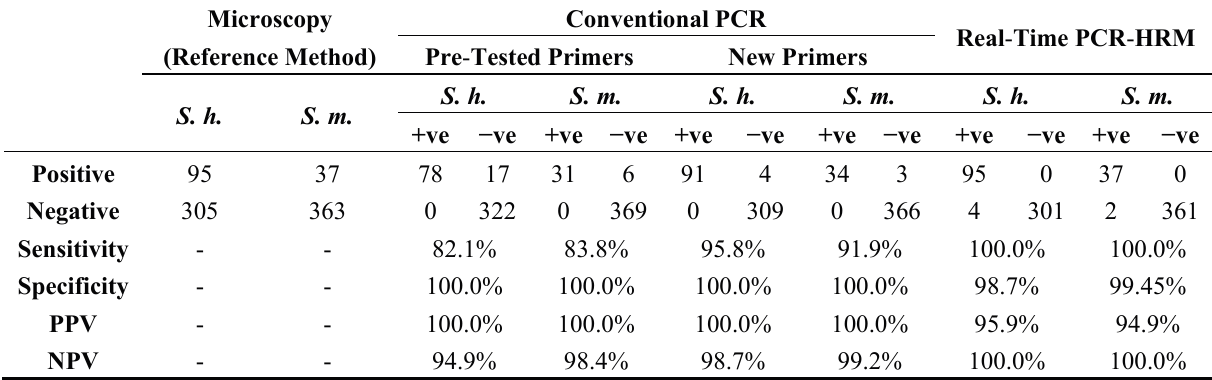
Table 2. Comparison between microscopy, conventional PCR and real-time PCR-HRM assays for the detection of S. haematobium and S. mansoni ( n =